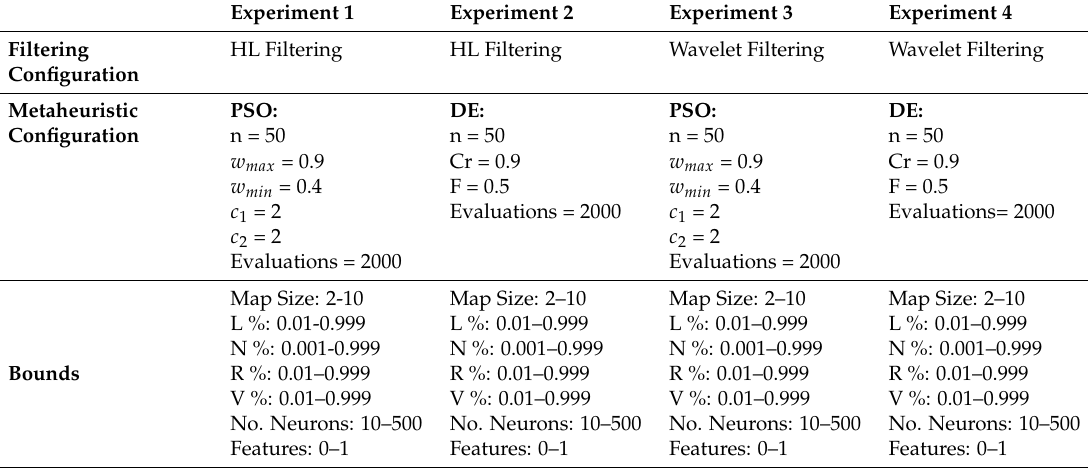
Table 5. Experimental configuration. Abbreviations: HL: combination of high-pass and low-pass filtering; PSO: particle swarm optimization; n: population; w max : maximum inertia weight; w min : minimum inertia weight; c 1 : accelerate constant 1; c 2 : accelerate constant 2; DE: differential